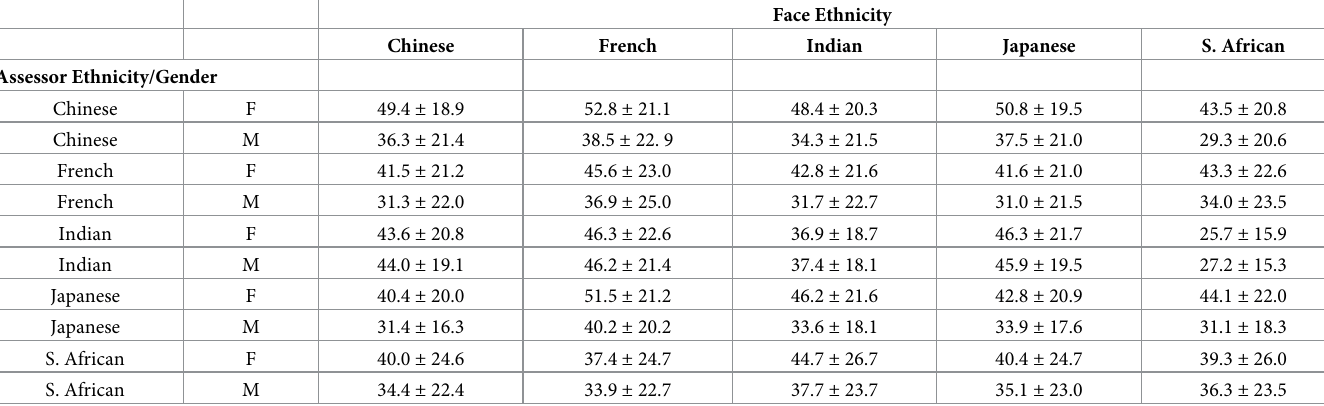
Table 5. Descriptive statistics of attractiveness, separately for assessor ethnicity and gender, and participant (“face”) ethnicity (mean ±